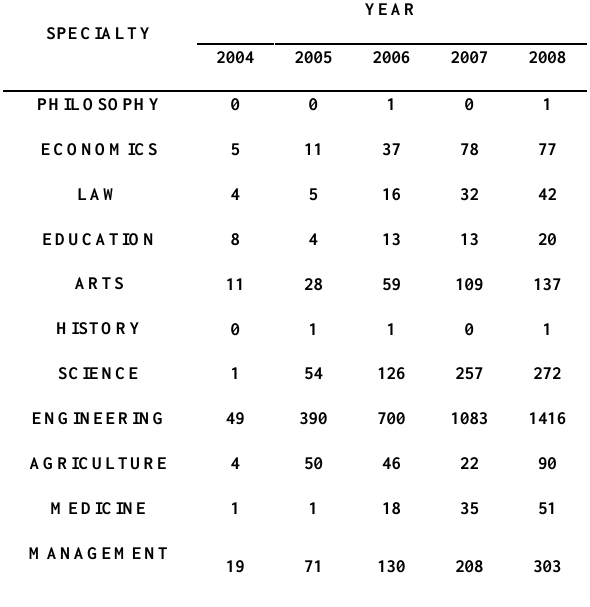
Table 1 The number of graduates majoring in different